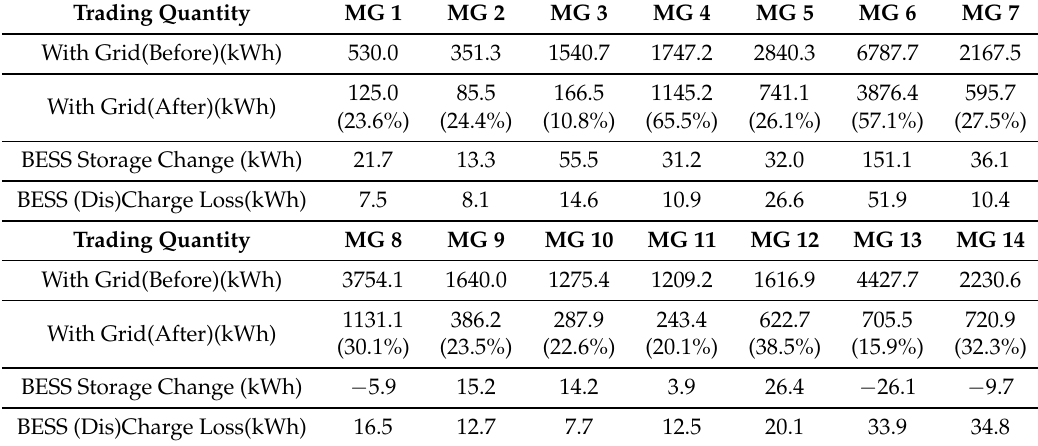
Table 1. Comparison of trading quantity before/after continuous double auction.